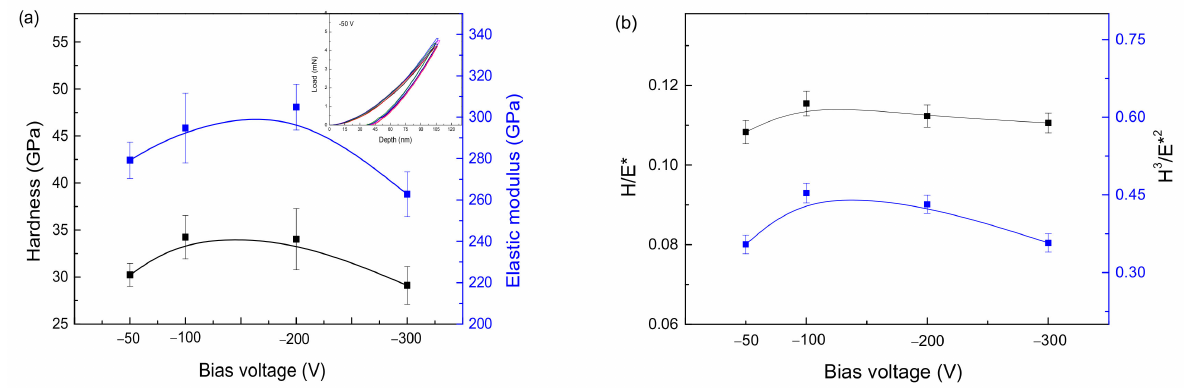
Figure 6. Hardness, Young’s modulus ( a ), and H/E* and H 3 /E* 2 ( b ) of Ti-DLC coatings deposited under different bias voltages, the load–displacement curves of Ti-DLC coatings at − 50 V on the top-right corner of ( a ).